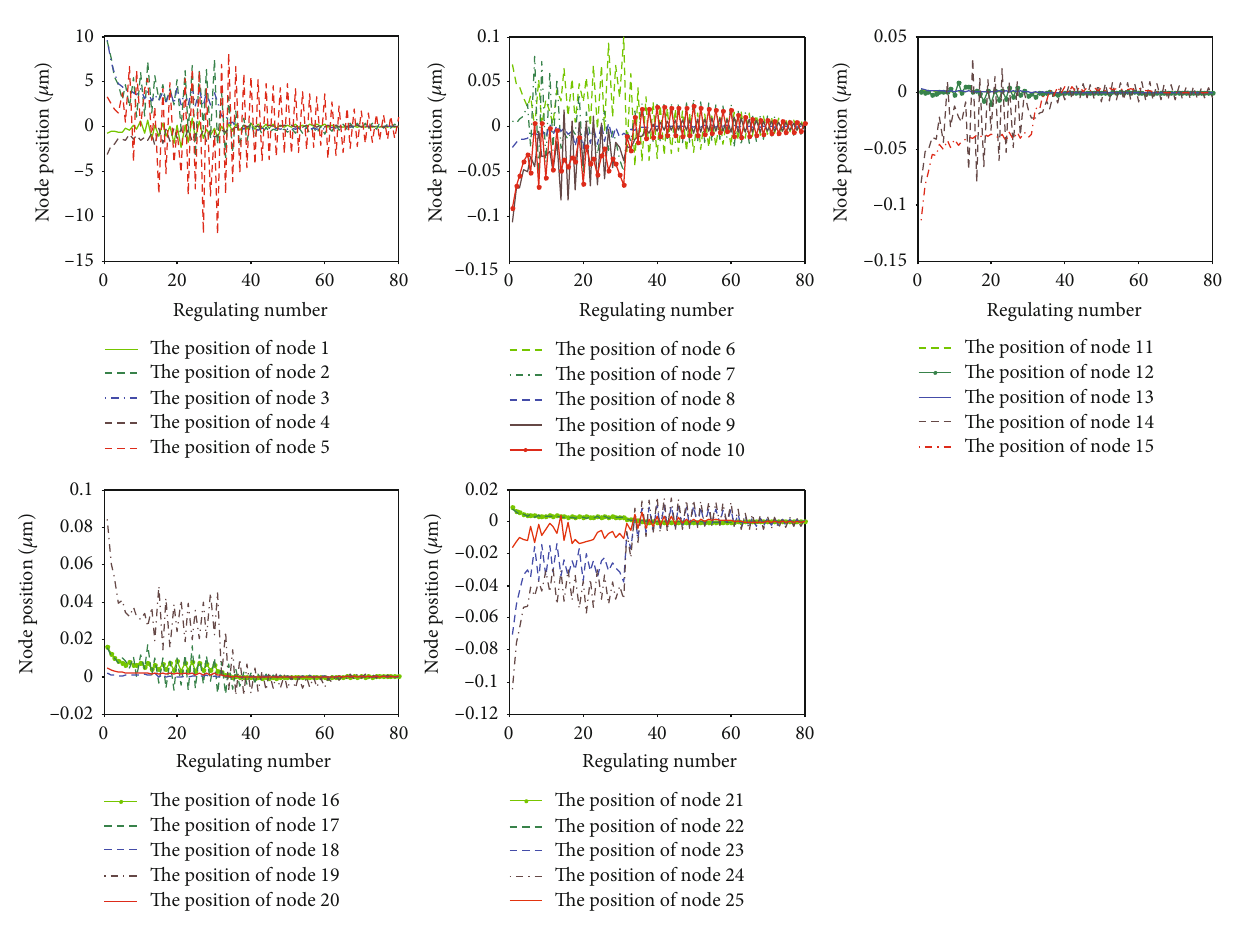
Figure 15: FNNQL adjustment curve with a disturbance of 90%.